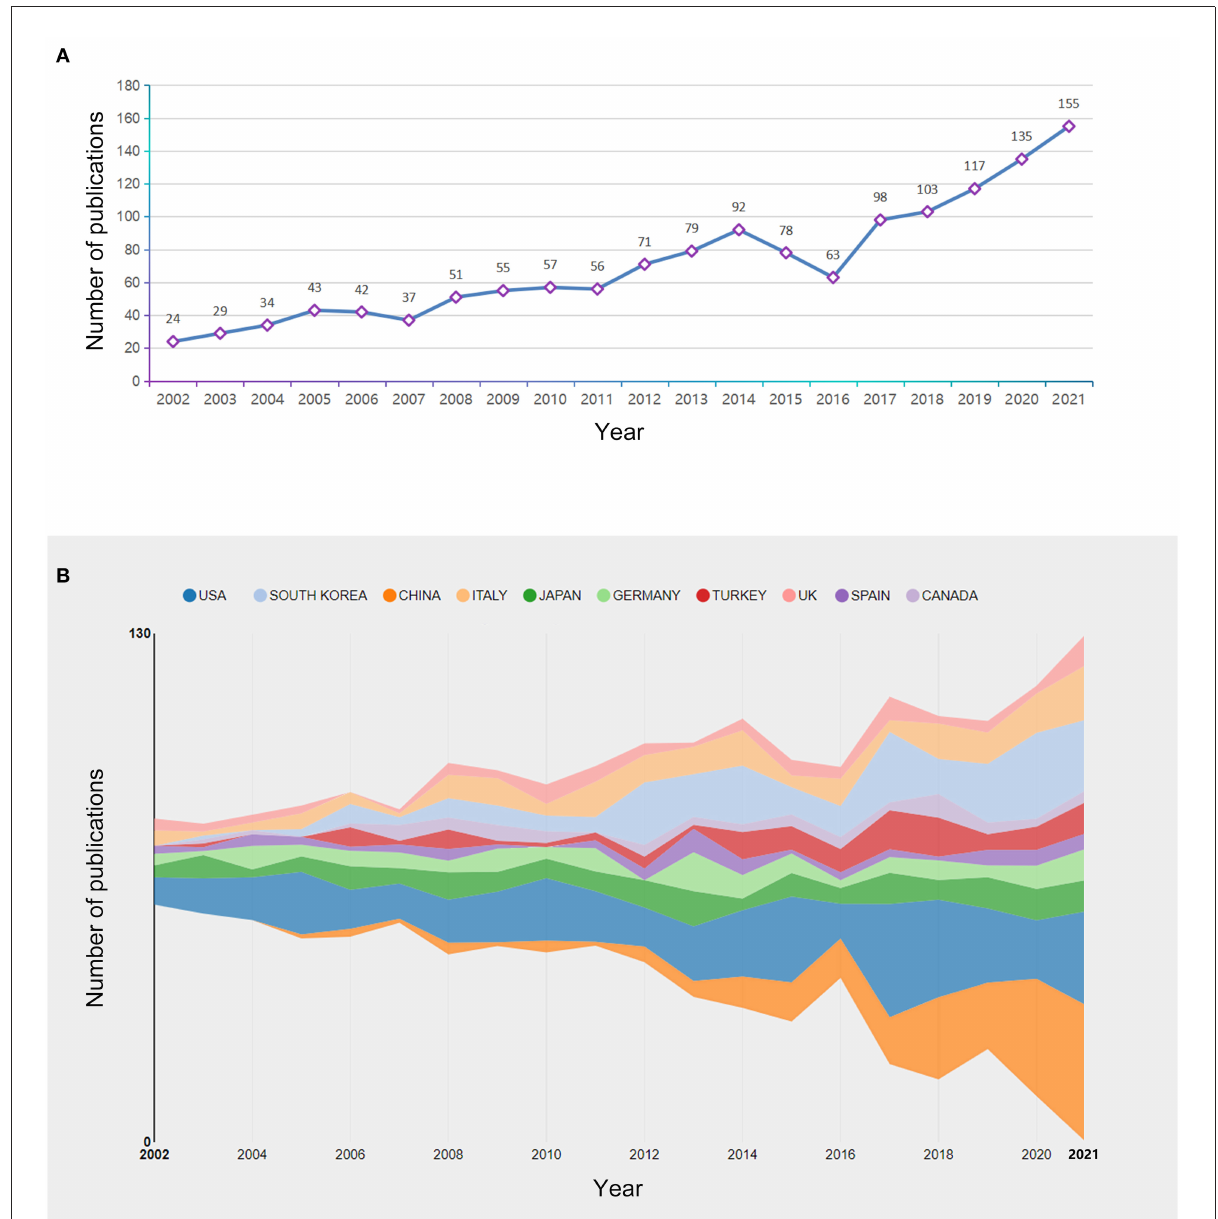
FIGURE2 (A) Yearly output of publications from 2002 to 2021. (B) Upward trend in publishing BPPV related research from 2002 to 2021 among the top-10 countries/regions with the most